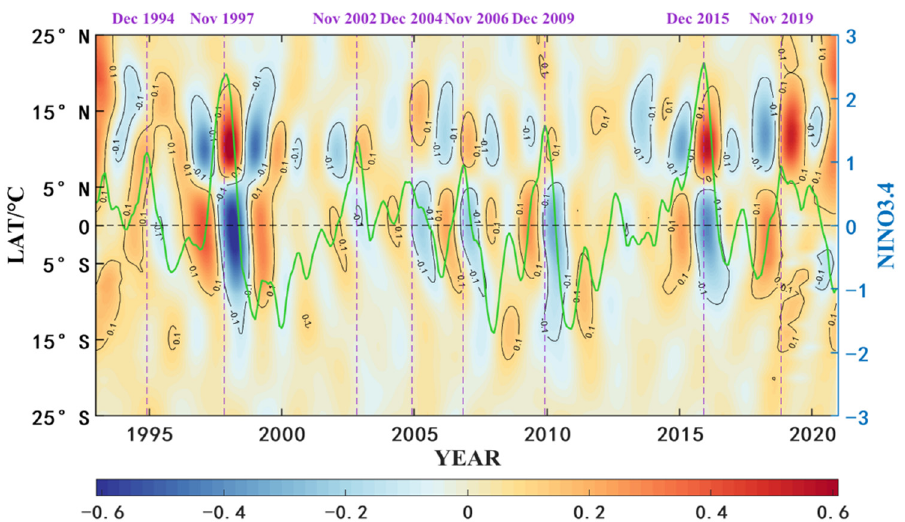
Figure 12. A Hovmöller diagram of the STT obtained by meridional averaging over the 25°S–25°N tropics based on the DORS dataset, along with the evolution of the NINO 3.4 index (green) (peaks of El Niño events since 1993 are marked with vertical dashed lines). The lines in the figure were smoothed by running a mean filter for 12 months.